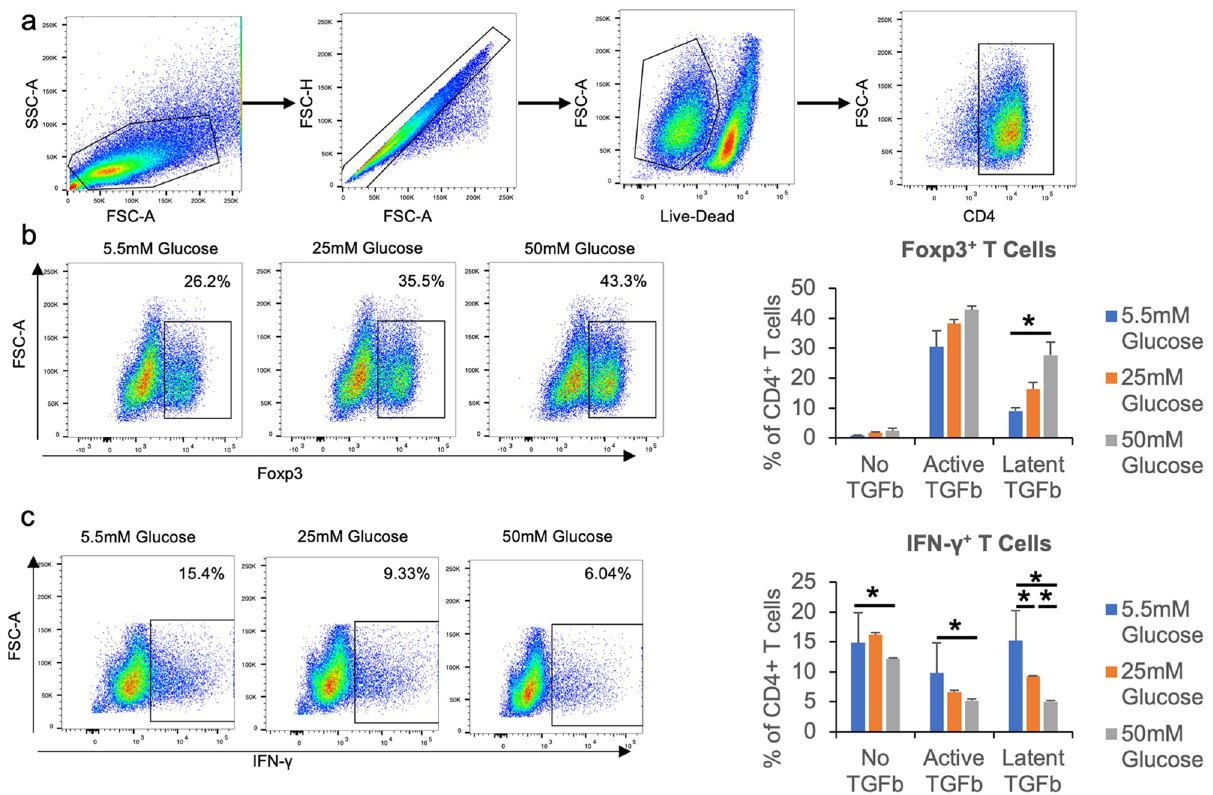
Fig 1. High glucose promotes iTreg differentiation. a – c , Na ï ve CD4 + T cells were isolated from C57BL/6 mice and cultured in 96-well plates with plate-bound anti-CD3 and soluble anti-CD28, and no, active, or latent TGF- β for 72 hours. Cells were then stimulated with Cell Stimulation Cocktail for 4 hours and then stained with fluorescence-conjugated antibodies and analyzed by flow cytometry. a , Representative flow cytometry gating for CD4 + T cell populations. b , Percentages of CD4 + Foxp3 + T cells in all CD4 + cells. c , Percentages of CD4 + IFN- γ + T cells in all CD4 + cells. N = 3, and data are presented as means ± S.E.M. � p < 0.05 by Student’s t test.